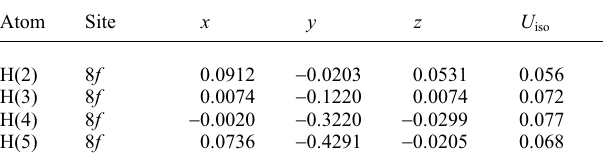
Table 2. Atomic coordinates and displacement parameters (in Å 2 )